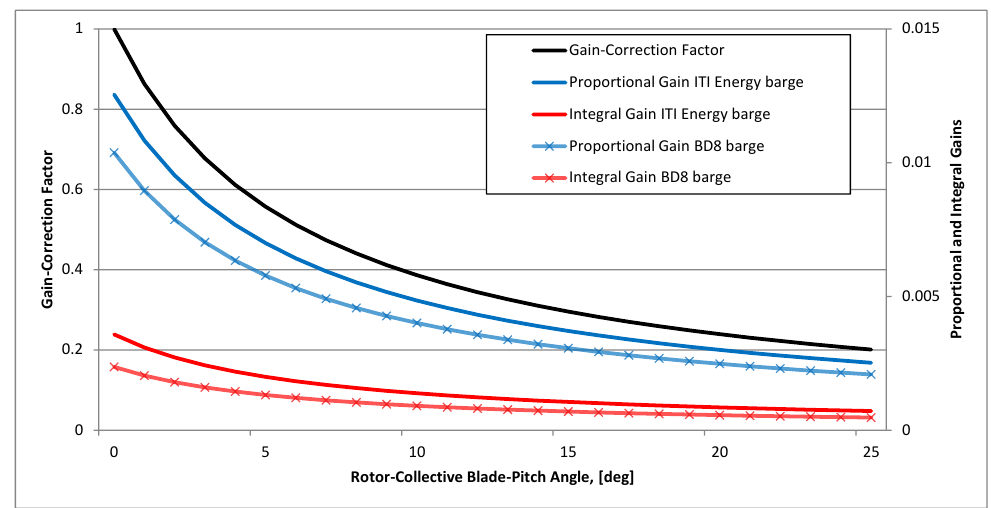
Figure 7. Blade-pitch detuned PI control